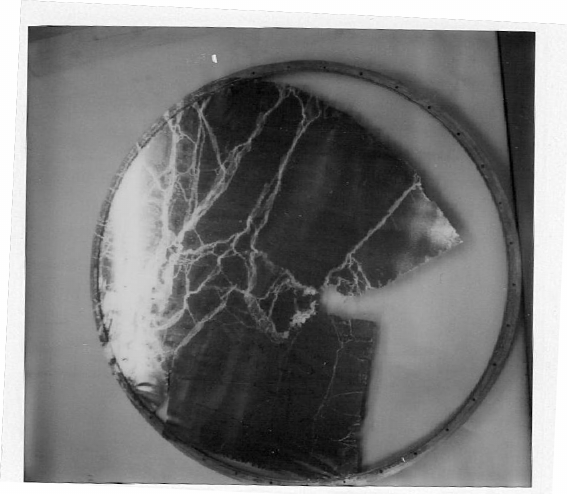
Fig. 7 : Foil that wa8.5s torn and collapsed by convection prior to its pickup on a mesh.